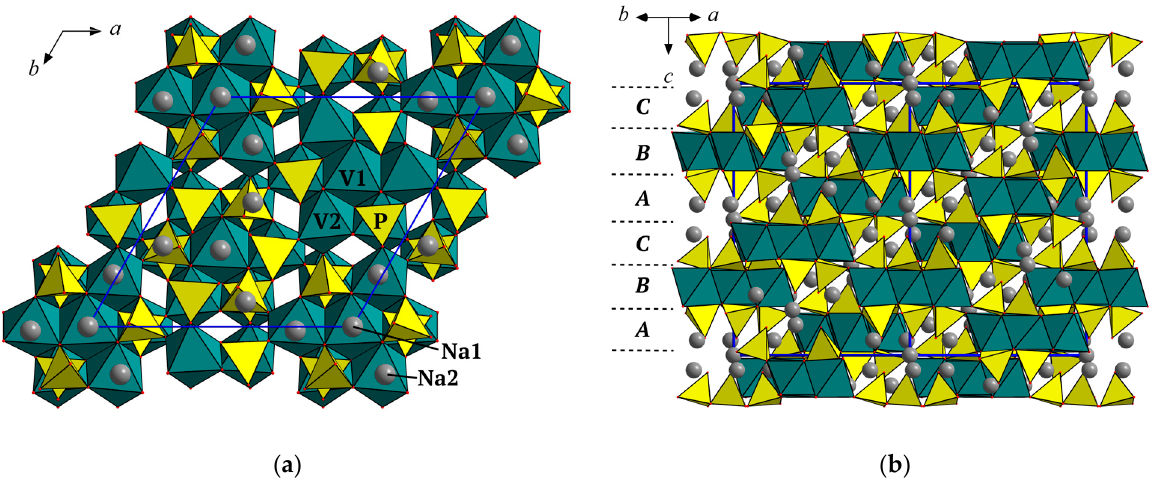
Figure 2. The main building units of the Na 7 V 4 (PO 4 ) 6 structure. ( a ) Atoms are shown in ellipsoid mode at a 90% probability level (symmetry operations: (i) − x + 2/3, − x + y + 1/3, − z + 5/6; (ii) − x + y , − x + 1, z ; (iii) − y + 1, x − y + 1, z ; (iv) x − y + 2/3, − y + 4/3, − z + 5/6; (v) y − 1/3, x +1/3, − z + 5/6; (vi) x + 1/3, x – y + 2/3, z + 1/6; (vii) y + 1/3, − x + y + 2/3, − z + 2/3). ( b ) The cluster of four vanadium octahedra in surrounding phosphate.